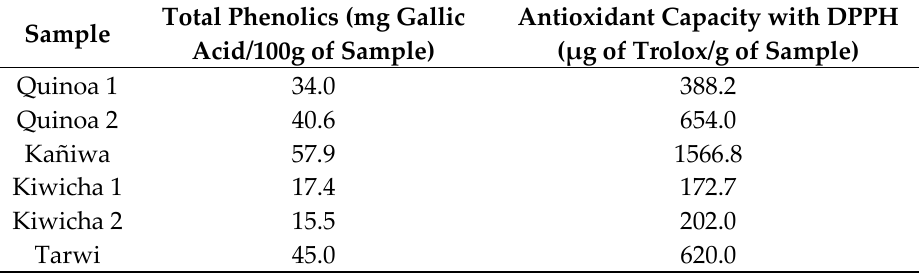
Table 3. Phenolic compounds and antioxidant capacity in Andean grains.